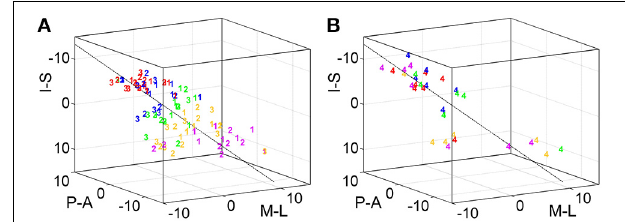
FIGURE 4 | Organization of digit area in BA 3b. For each of the 7 subjects that presented with significant activation for all phalanges and bases, all peak vertices were normalized by the respective subject’s mean value across phalanges (but not bases; A-P, anterior-posterior; M-L, medial-lateral, I-S, inferior-superior; D1, magenta; D2, yellow; D3, green; D4, blue; D5, red; all units in 1mm). (A) Normalized peak-vertex coordinates for p1 ( = 1), p2 ( = 2), and p3 ( = 3). (B) Normalized peak-vertex coordinates for p4 ( = 4).